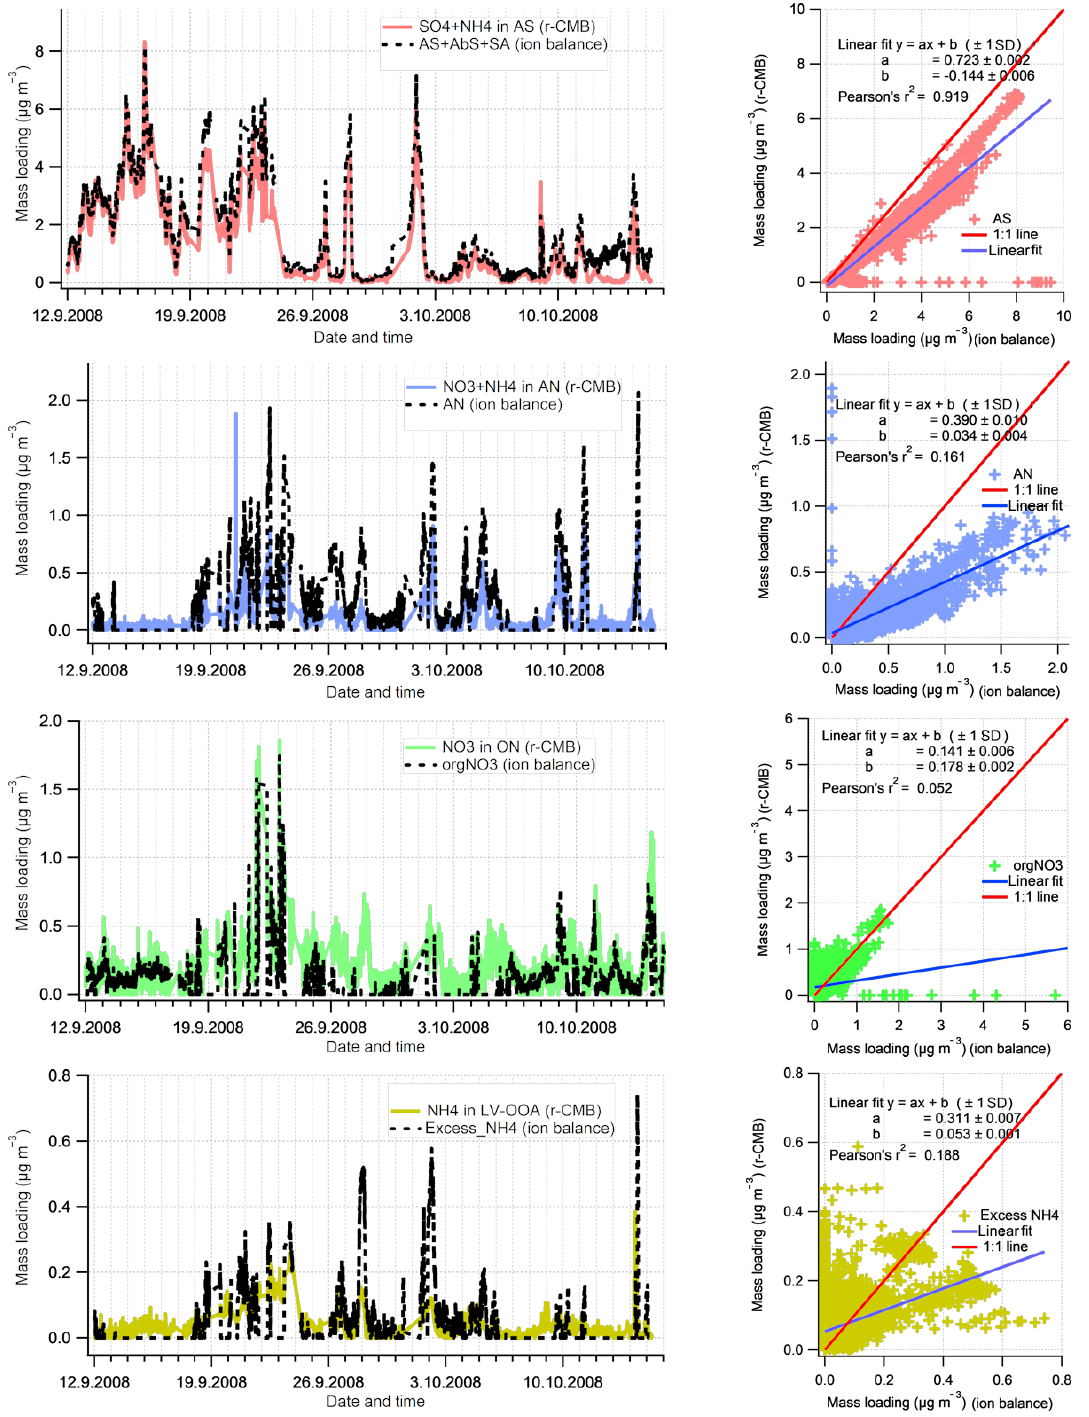
Figure 10. Comparison of Inorganics apportionment methods (r-CMB and ion balance scheme. The estimates from the ion balance scheme (Sect. 2.4.1) are shown in black, and the r-CMB model results in colour. The linear fits (right panels) represent the data poorly due to high amount of zero-value points and